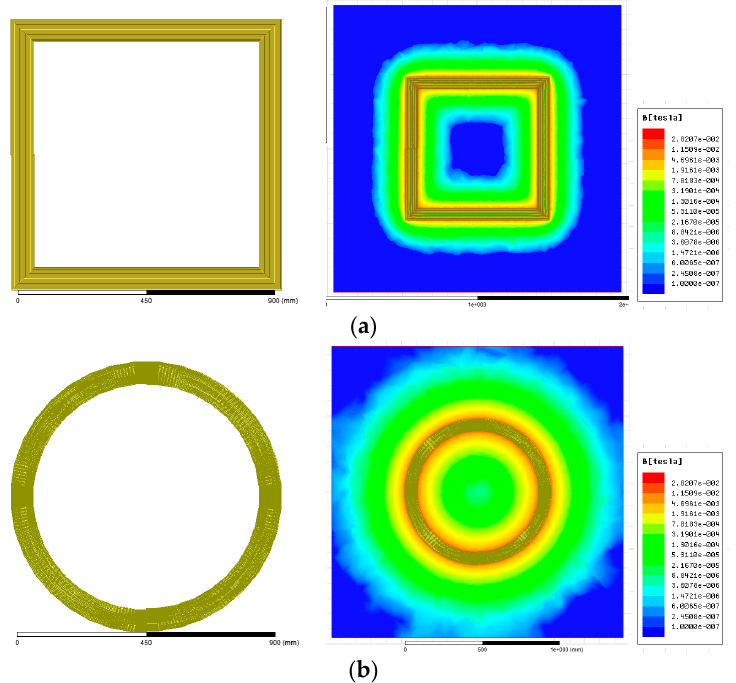
Figure 10. The magnetic flux distributions. ( a ) The square coil; ( b ) The circular coil.